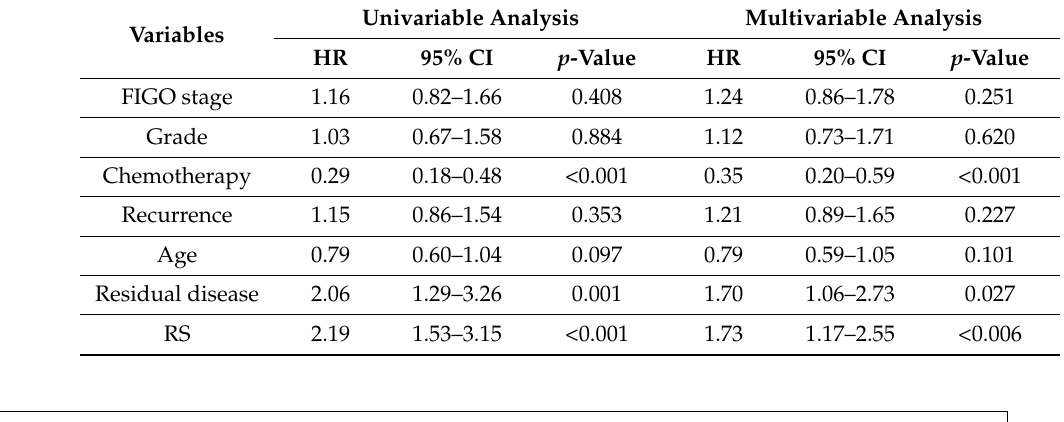
Table 3. Univariable and multivariable Cox regression to analyze the relationship between the RS and clinical prognosis.